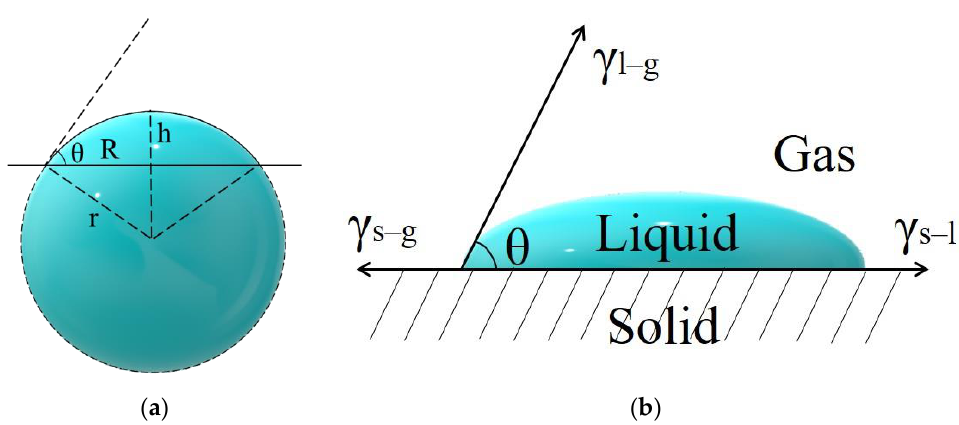
Figure 2. ( a ) Computational model of spherical cap droplet; ( b ) schematic side view of the contact between the droplet and substrate.